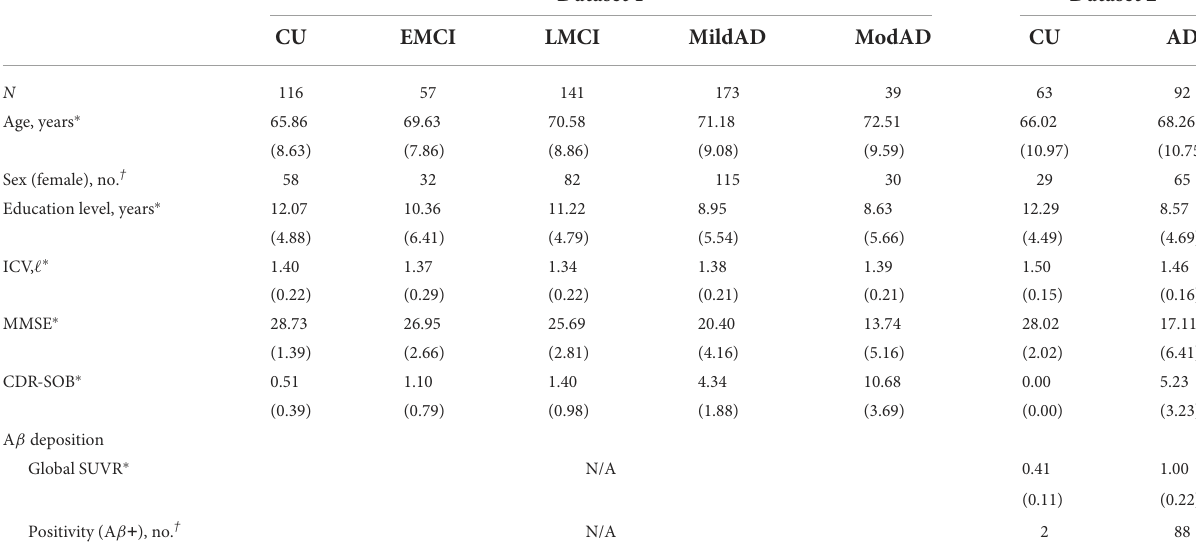
TABLE 1 Demographic information according to the stage of Alzheimer’s disease